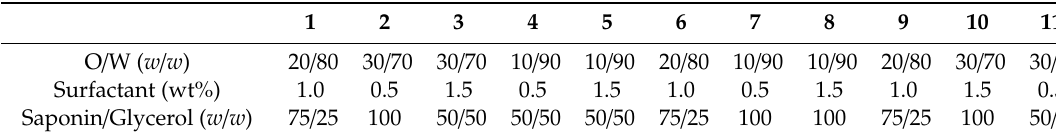
Table 1. Sample compositions used in the design of experiments (DOE).